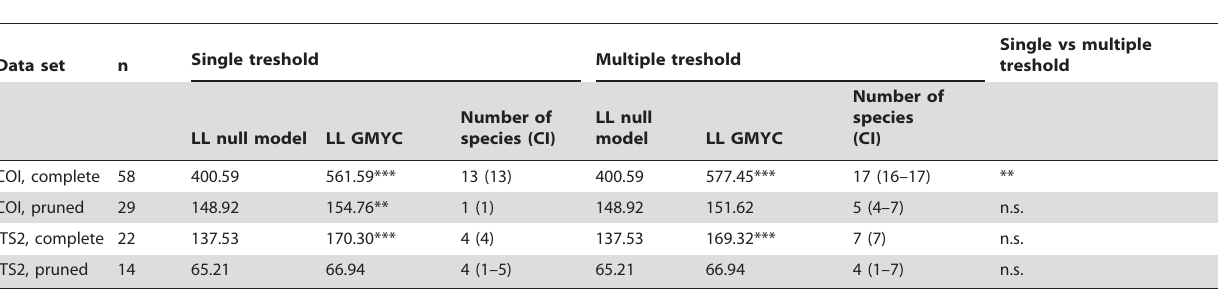
Table 1. Summary of the analyses for the presence of darwinulid species with the GMYC method.